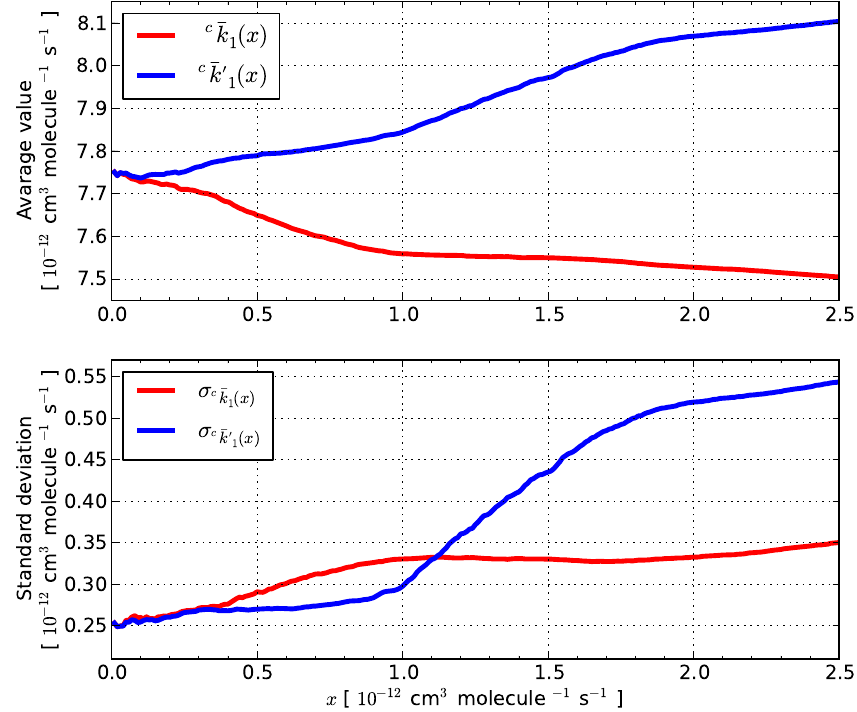
(x) (red) on x in the time range between start time of 18:30–19:30 MLT and end 1 (blue) and σ ¯ (red) on x in the same time range (bottom). k 1 ( 0 ) k 0 ( 0 ) 1 ¯ k ( x ) (blue) and c ¯ k 1